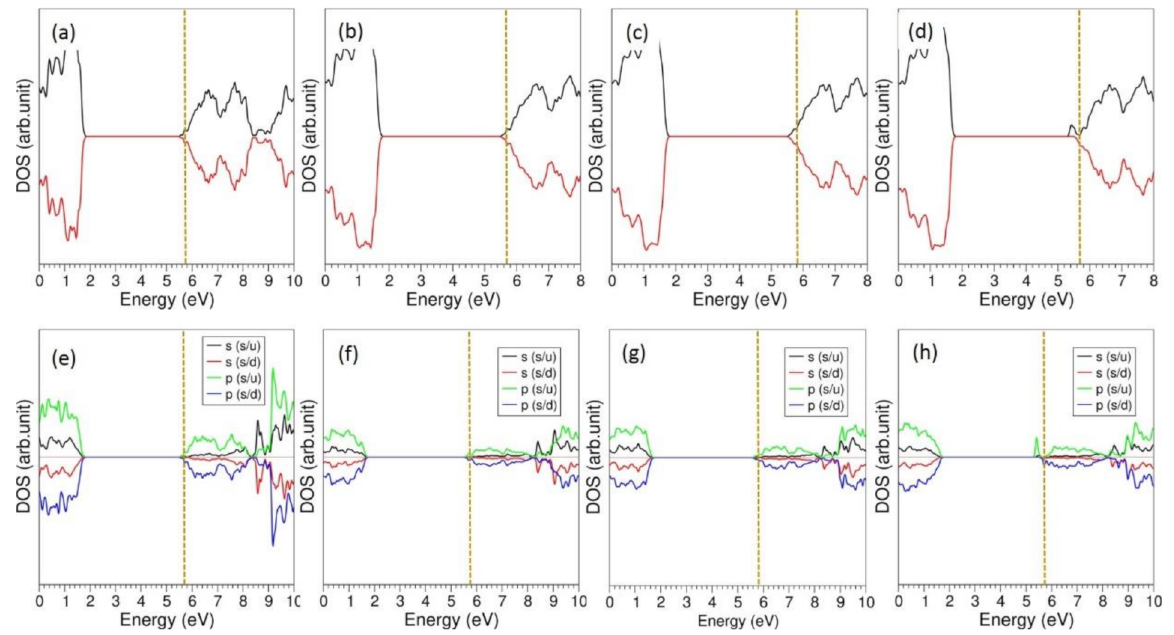
Figure 8. Total DOS plots of ( a ) a single Li, ( b ) 2Li, ( c ) 3Li and ( d ) 4Li incorporated in Li 2 ZrO 3 . Corresponding Li atomic DOS plots ( e – h ) are also